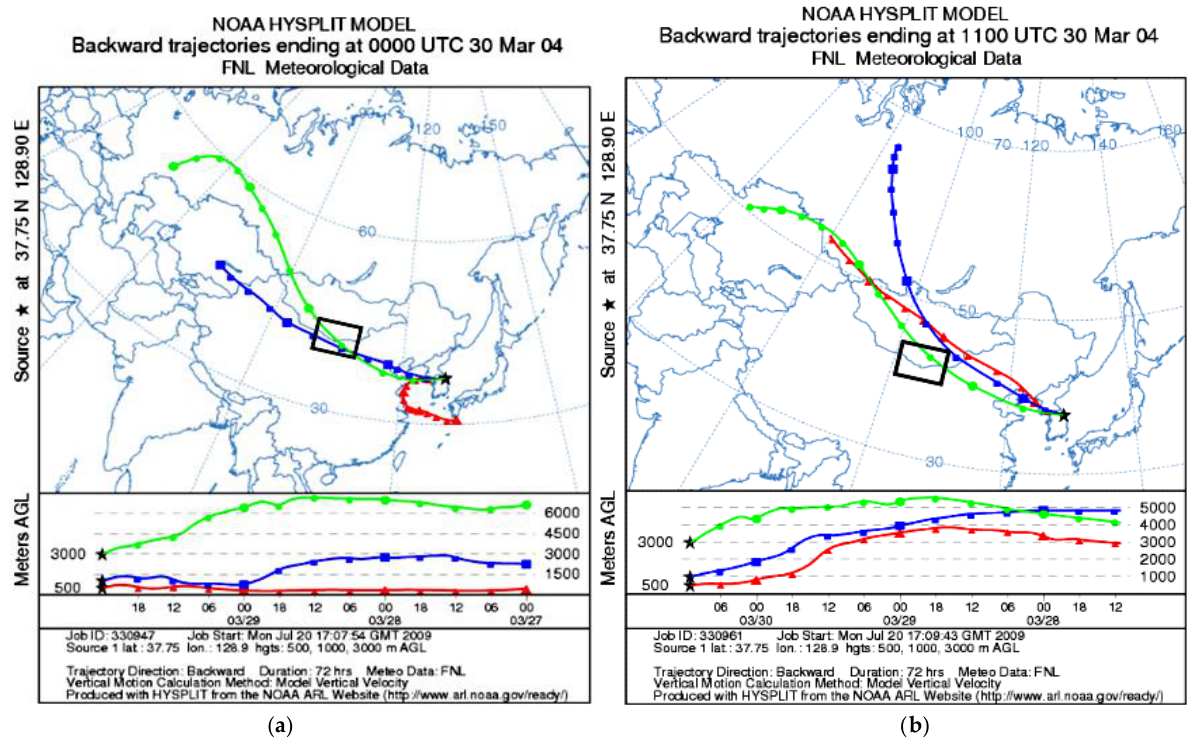
Figure 12. ( a ) Particle backward trajectory by HYSPLIT model at 09:00 UTC (00:00 LST), 30 March 2004, and ( b ) 12:00 UTC (21:00 LST)). A small square denotes the Gobi Desert.